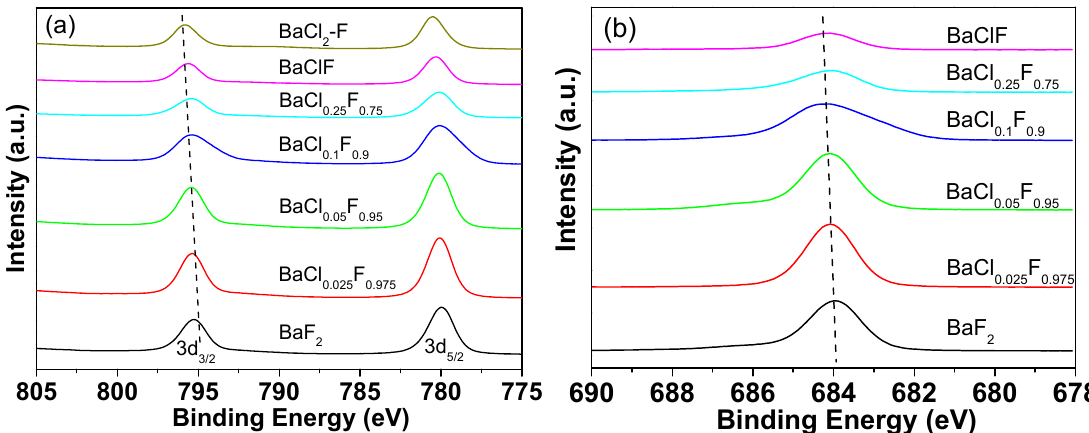
Figure 8. High resolution XPS of ( a ) Ba 3d and ( b ) F 1s spectra of BaF 2 and barium chlorofluoride catalysts before reactions.